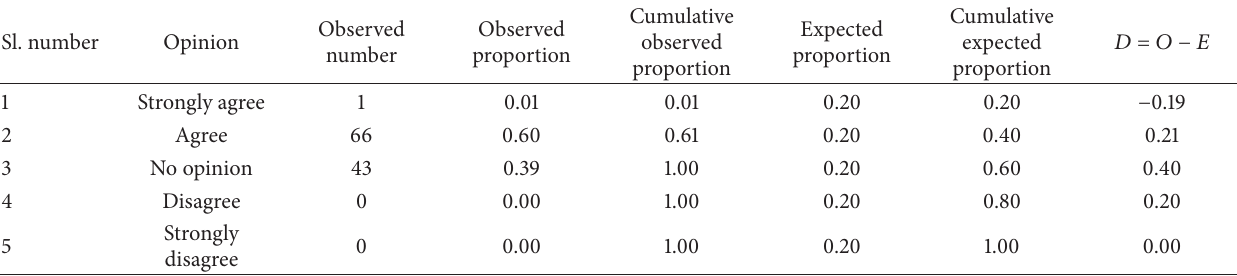
Table 12: Giving advice at the time of facing the problems, KS Test. Sl.